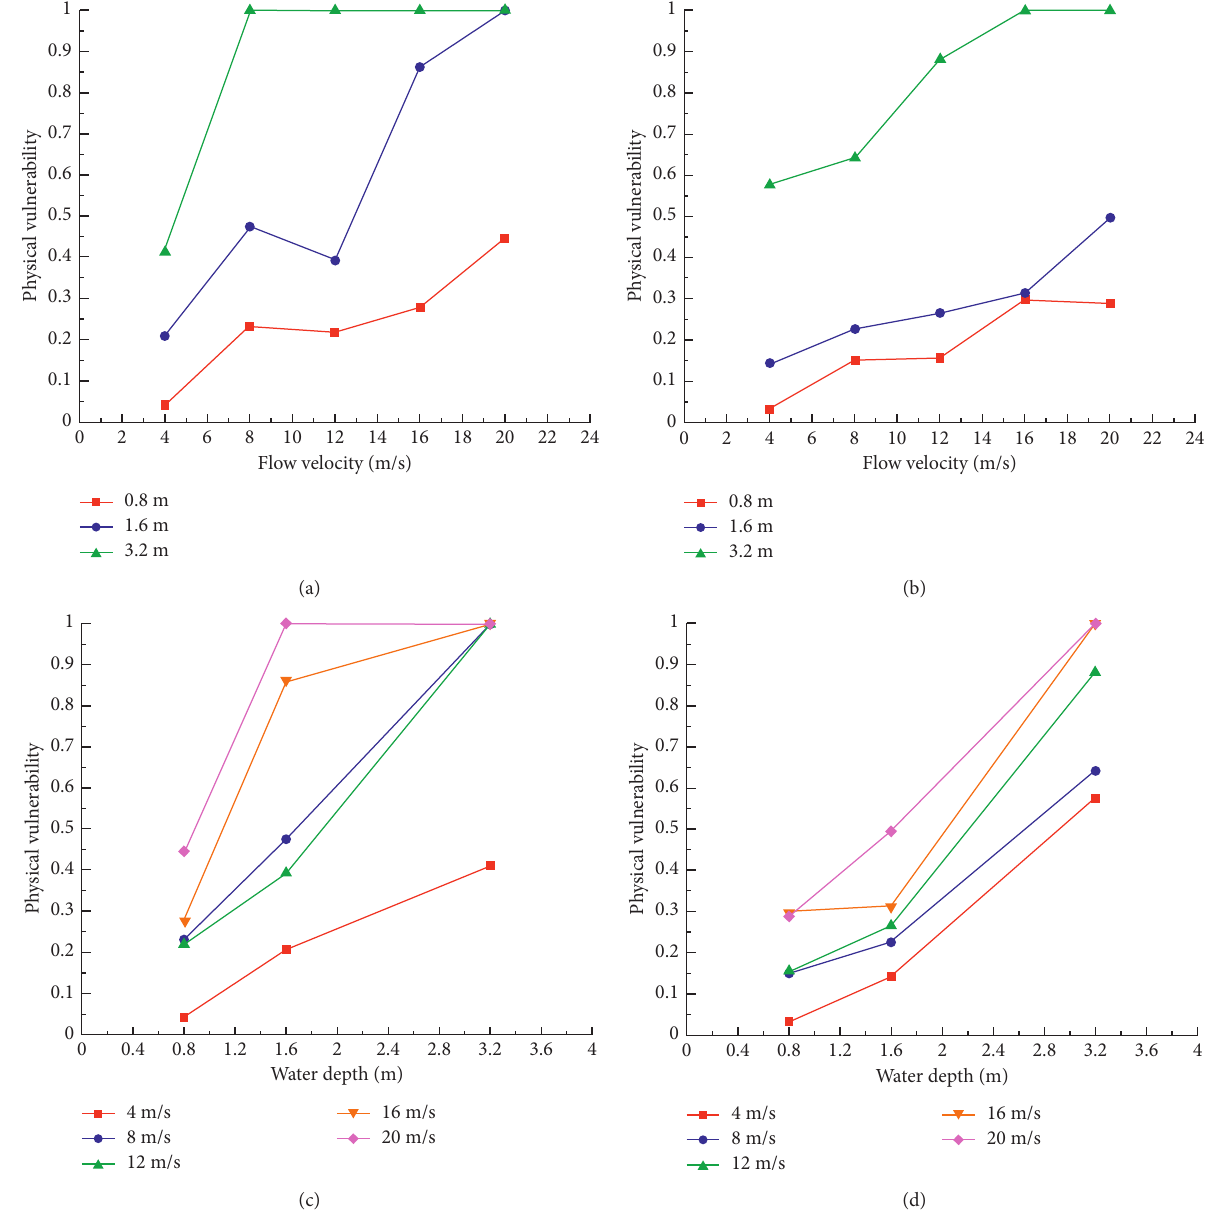
Figure 15: Physical vulnerability: (a) flow velocity evolutions, building without structural measures, (b) flow velocity evolutions, building with structural measures, (c) water depth evolutions, building without structural measures, and (d) water depth evolutions, building with structural